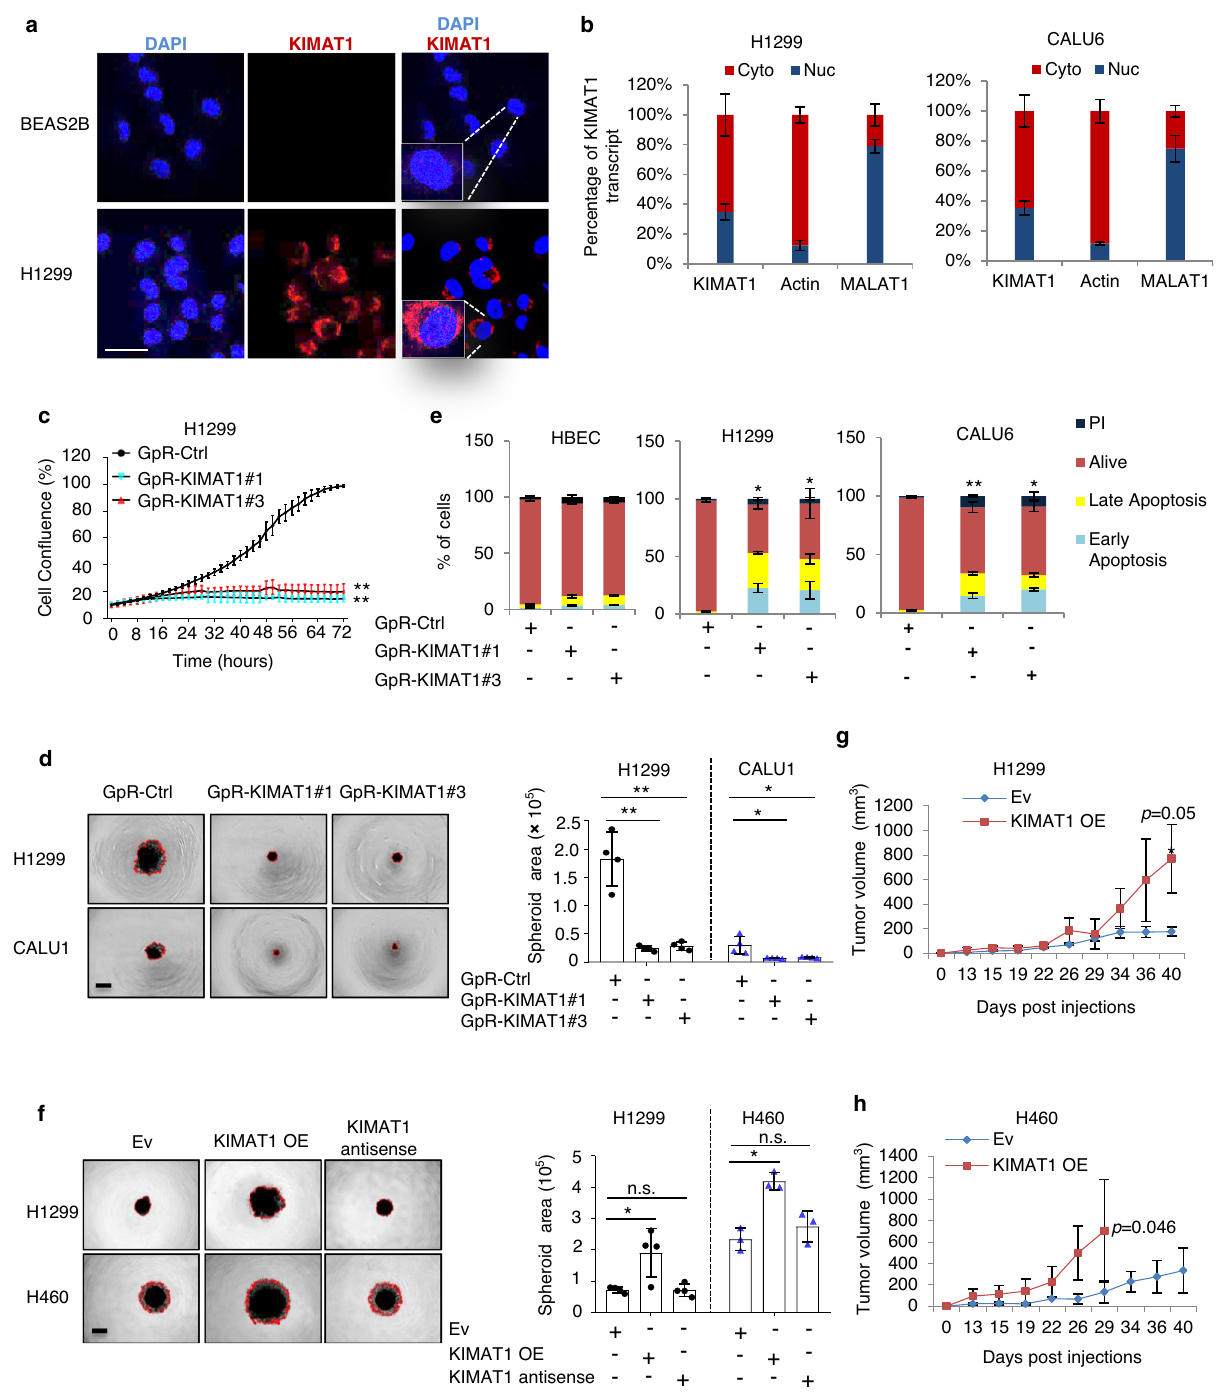
Fig. 3 KIMAT1 is an oncogenic lncRNA in NSCLC. a Confocal microscopy images of KIMAT1 smFISH (Red) in different cell lines. Images are representative of two biological replicates. Nuclei were stained with DAPI (Blue). Scale bar, 75 μ m. b qRT-PCR analysis for KIMAT1 following cytoplasmic (cyto) and nuclear (nuc) fractionation of cell lysates, n = 3. c Cell proliferation assay upon transfection with two different KIMAT1 GpRs, n = 4. GpR-KIMAT1#3 vs Ctrl **1.14E − 09; GpR-KIMAT1#1 vs Ctrl **1.66E − 07. d 3D invasion assay of H1299 cells transfected with two different KIMAT1 GpRs and quanti fi cation of the tumorsphere area invading the matrigel, n = 4. GpR-KIMAT1#1 vs Ctrl **0.000601 and GpR-KIMAT1#3 vs Ctrl **0.000713 (H1299); GpR-KIMAT1#1 vs Ctrl *0.026964 and GpR-KIMAT1#3 vs Ctrl *0.033348 (CALU1). Scale bar, 500 μ m. e Quanti fi cation of Annexin V staining upon GpRs transfection in multiple cell lines, n = 3. *0.013189 and *0.031027 (H1299); **7.99E − 05 and *0.020508 (CALU1). f 3D invasion assay of H1299- KIMAT1 and H460- KIMAT1 stable cells and quanti fi cation of the tumorsphere area invading the matrigel. KIMAT1 antisense was used as control. n = 4 (H1299) and n = 3 (H460). KIMAT1 OE vs EV *0.022 (H1299); KIMAT1 OE vs EV *0.002105 (H460). Scale bar, 500 μ m. g, h Tumor growth curves of xenograft mouse models derived from cell lines with stable overexpression of KIMAT1 ( n = 8) compared to control mice ( n = 8). Data show mean ± S.D. p values were calculated by two tailed Student ’ s t